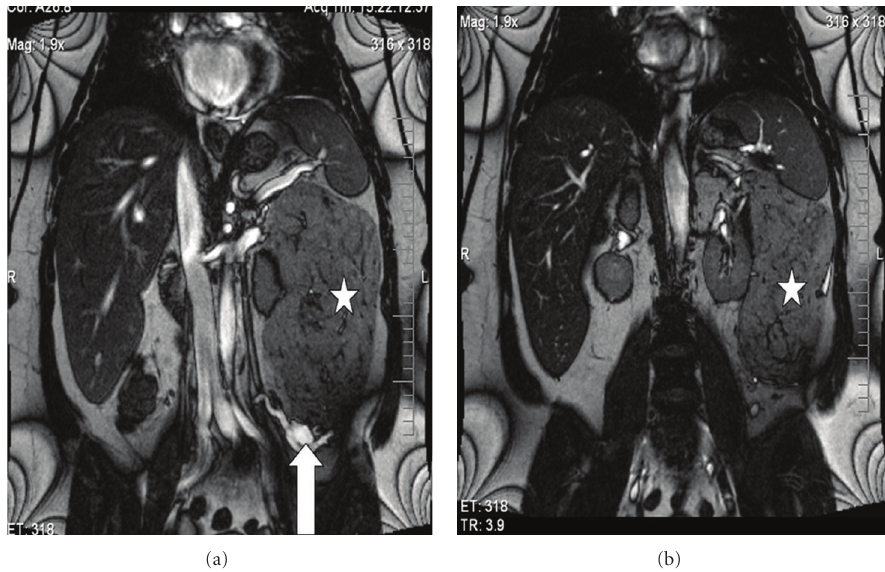
Figure 2: Abdominal magnetic resonance imaging demonstrating a large fatty encapsulated mass (white asterisk) measuring 19.3 cm × 13.5cm × 10.7 cm with prominent vascularity (white arrows). The anatomic relationship between the mass and the left kidney can be well seen in Figure 2(b).